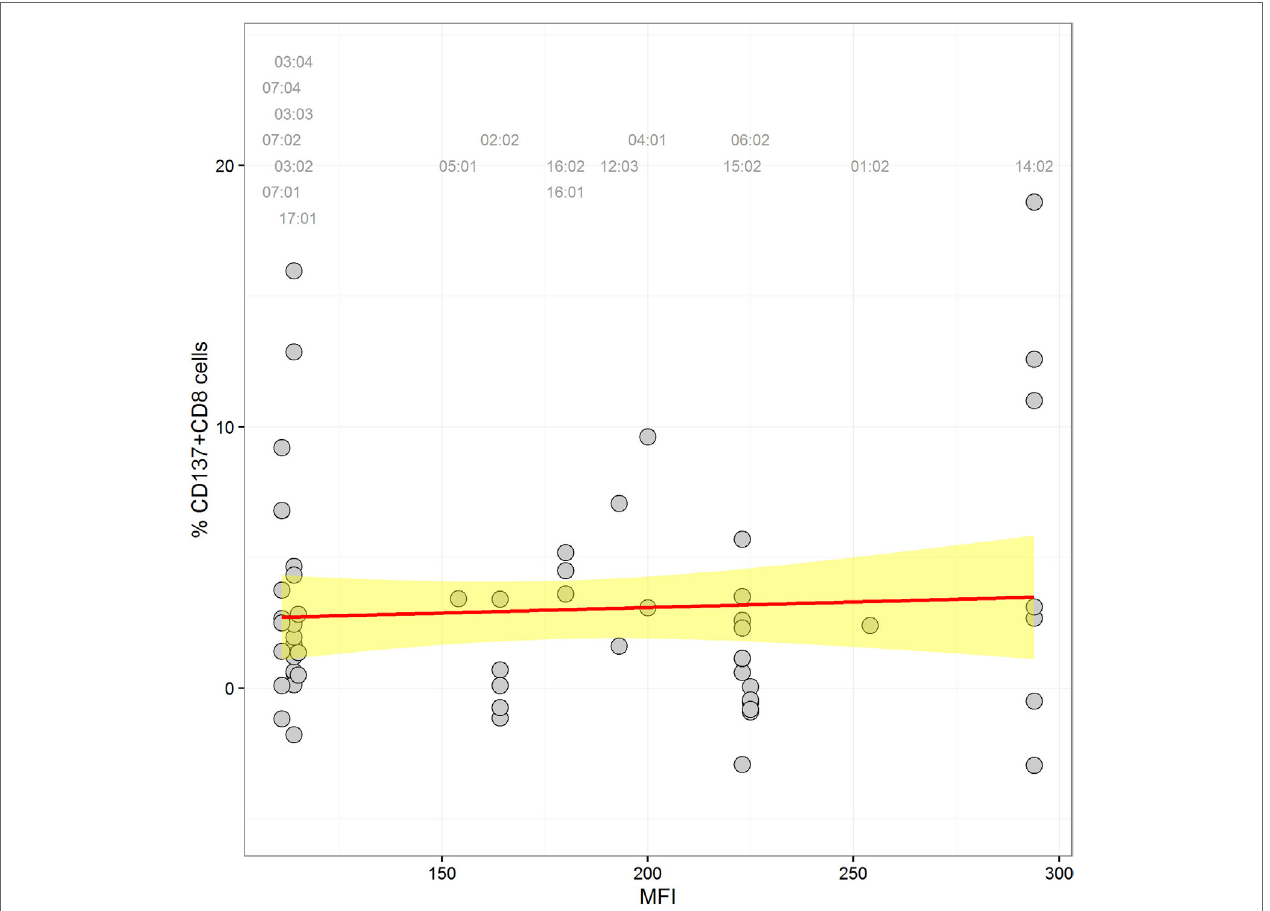
FigUre 3 | scatter plot of hla-c expression [mean fluorescence intensity (MFi) values according to ref. (5 , 15)] and alloreactivity (% Δ cD137 + cD8 + cells) . A label is plotted for each stimulator allele at the top of the graph, indicating its corresponding MFI value. The linear regression through the data points is shown in red, and the confidence interval is in yellow (coefficient = 0.004, p =